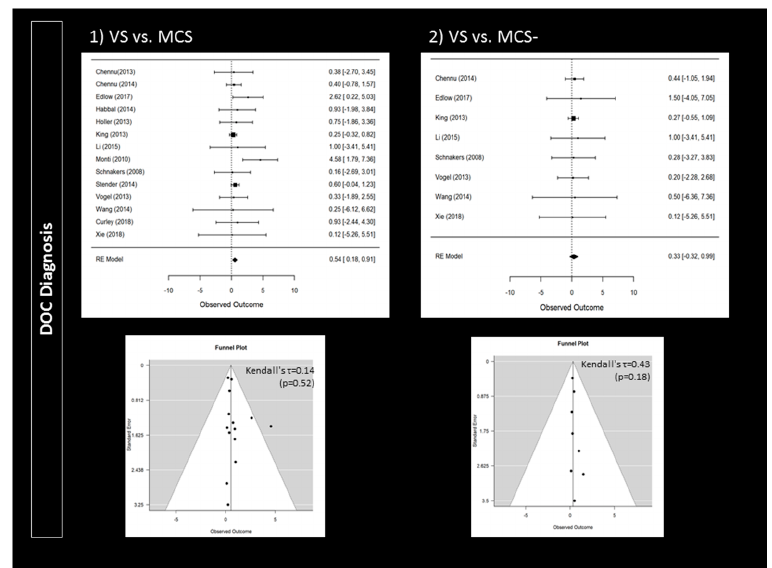
Figure 1. PRISMA Flow Diagram.